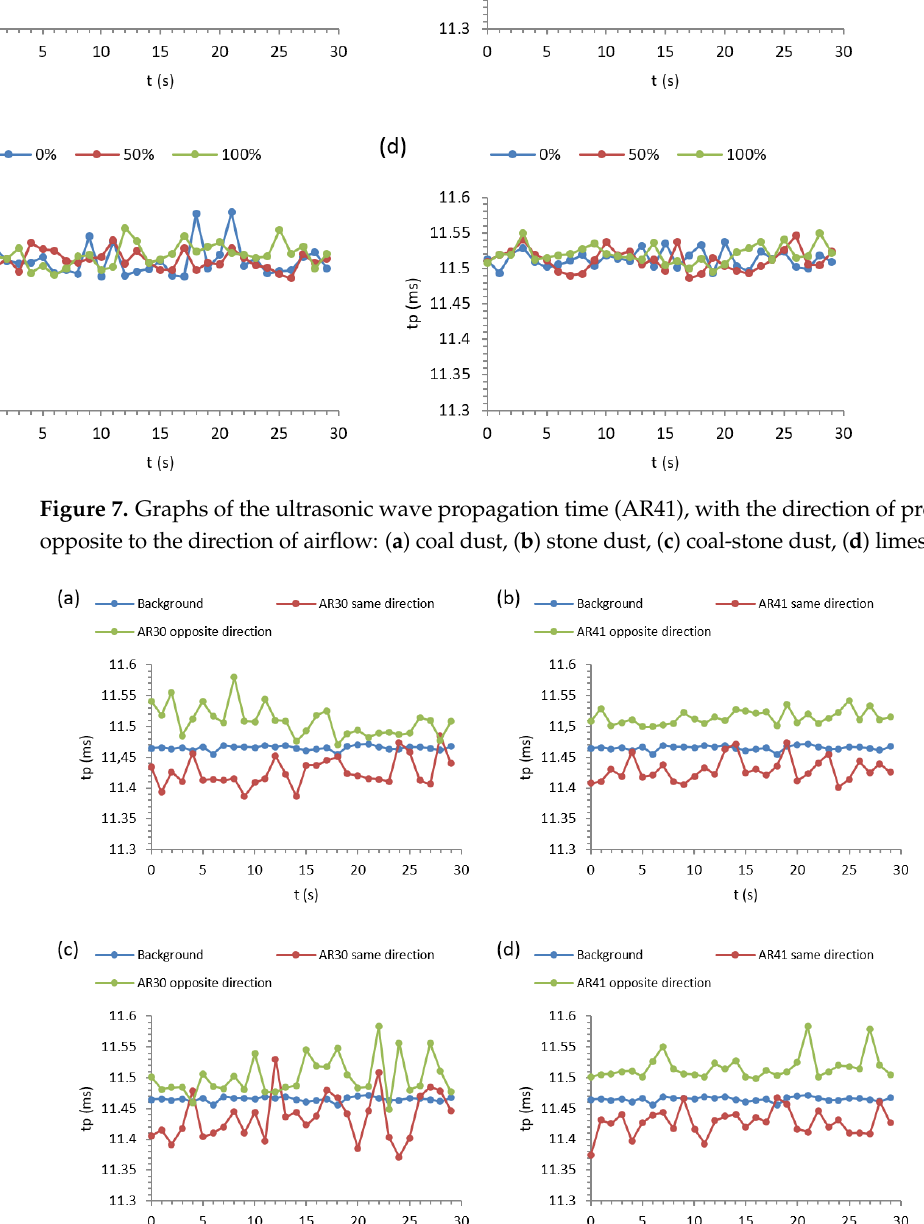
Figure 8. Graphs of the measured propagation times of ultrasonic waves, with maximum dustiness (100% setting) and different directions of ultrasonic waves propagation: ( a ) coal dust and AR30 transducers, ( b ) coal dust and AR41 transducers, ( c ) stone dust and AR30 transducers, ( d ) stone dust and AR41